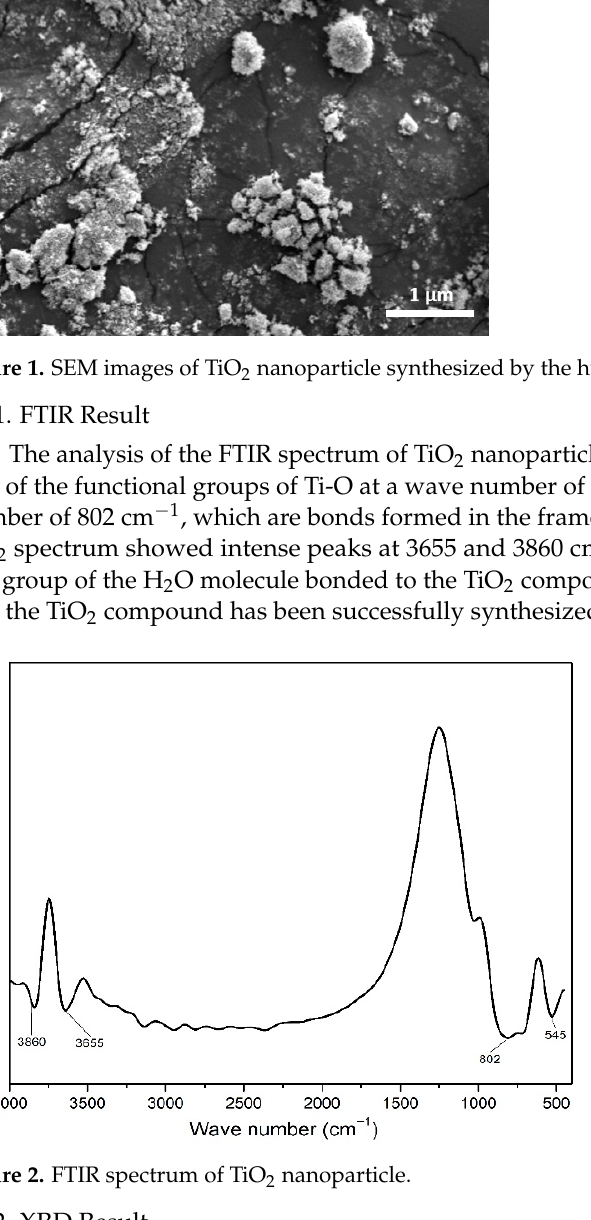
Figure 2 . FTIR spectrum of TiO 2